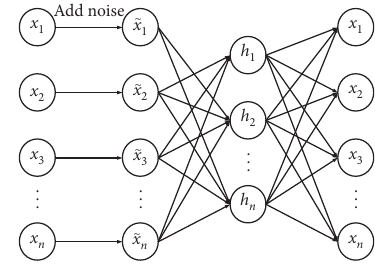
Figure 4: Denoising autoencoder.